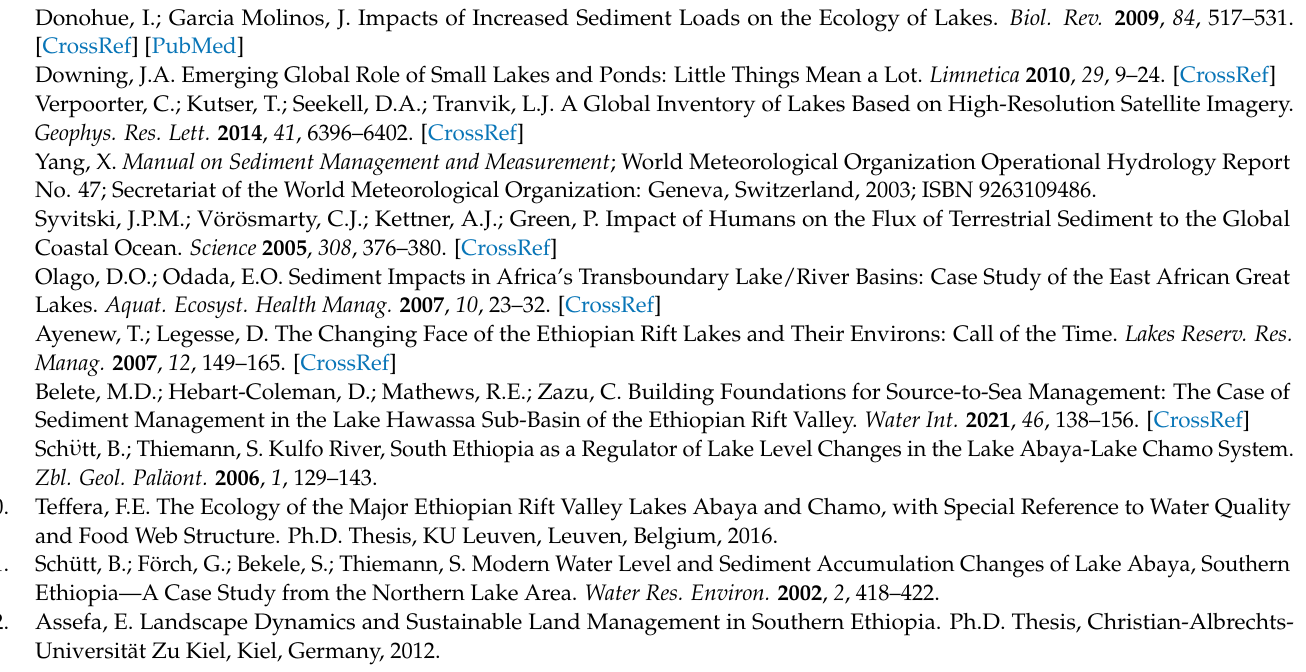
Figure A5. Relationships between road density and GLD, for active gullies of each river catchment. Slope represents the mean slope angle (degree) of each sub-catchment and n represents the number of sub-catchments of each slope-angle class.